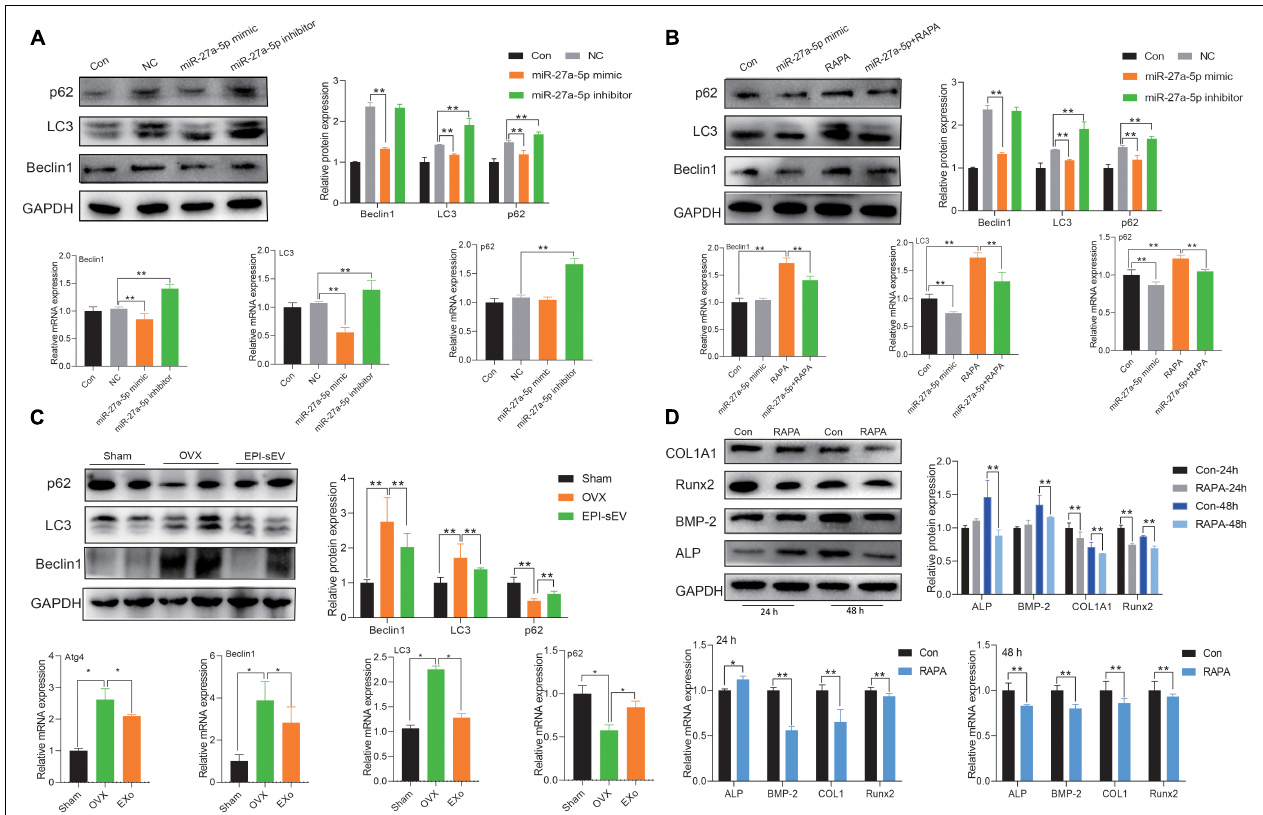
FIGURE 7 | miR-27a-5p-targeted Atg4B mediated autophagy-induced osteogenesis. (A) The expression of autophagy-related factor in miR-27a-5p gain and loss experiments in osteoblasts; the normalized data represented mean ± SD. (B) Rescue experiments with the treatment of the miR-27a-5p mimic and rapamycin in osteoblasts. (C) Expression autophagy-related factor in the OVX and EPI-sEV groups; the normalized data represented mean ± SD. (D) Expression of osteogenic-related factor with the treatment of rapamycin for 24 and 48 h in osteoblasts; the normalized data represented mean ± SD. * p < 0.05, ** p < 0.01; analyses were performed twice and obtained comparable